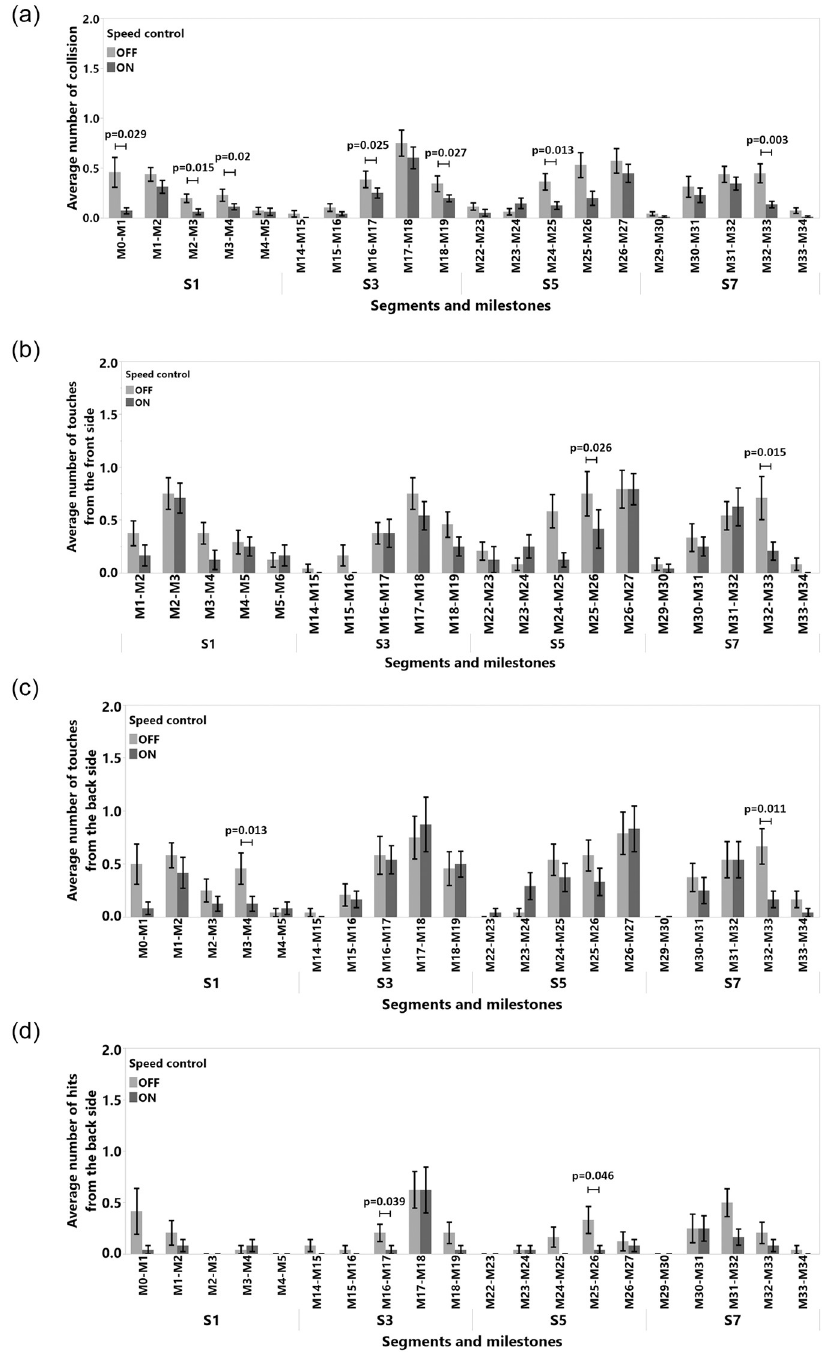
Fig 13. Detailed milestone analysis for average number of (a) collisions, (b) front touch, (c) back touch and (d) back hit. Detailed time and front hit analysis per milestone is shown in Fig 12. 7-very unlikely, M = 2.58, SD = 1.55). Half of the participants preferred the keyboard and the other half the gamepad. Participants also reported that they only felt moderate physical and mental fatigue after the experiment (1-I feel very rested, 7-I feel very tired, for physical and mental fatigue of M = 3.25, SD = 1.09 and M = 3, SD = 1, respectively).